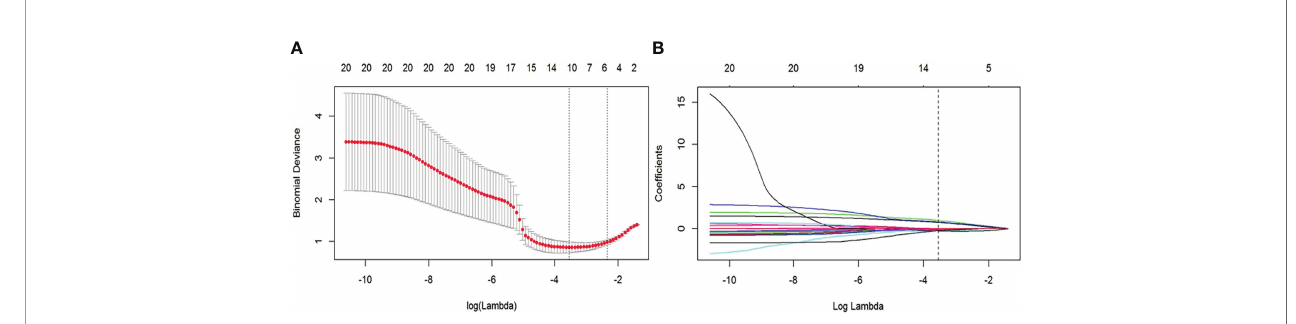
FIGURE 2 | Feature selection with the least absolute shrinkage and selection operator (LASSO) regression method. (A) Variation of tuning parameter ( l ) for LASSO model, using 10-fold cross-validation. The vertical dotted lines indicate the best l =0.028 was selected with a least binomial deviation. (B) The LASSO coef fi cient pro fi les with radiomic features of different log ( l ). The vertical dotted line was the best l with 10 radiomic features with non-zero coef